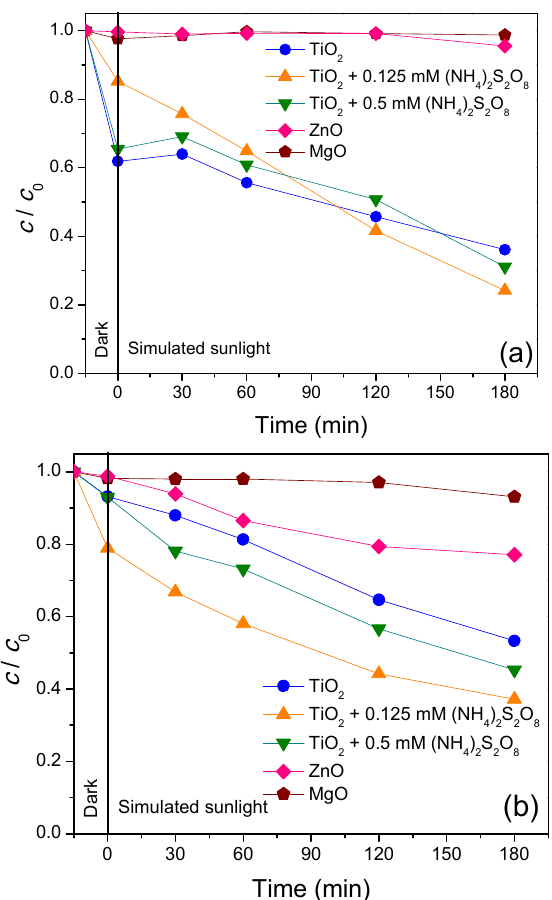
Figure 10. Removal of herbicides ( a ) TEM and ( b ) FLU (0.05 mM) from water using different catalysts (0.5 mg/mL) in the presence/absence of (NH 4 ) 2 S 2 O 8 under SS.